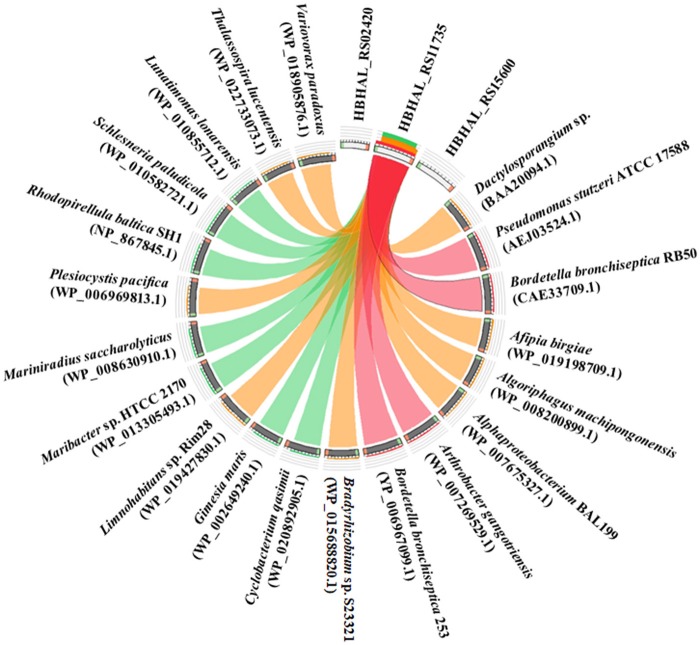
Circos plot showing the relationships between the products of three candidate genes (HBHAL_RS02420, HBHAL_RS11735, HBHAL_RS15600) and proteins annotated as PH-4 in GenBank. The plot was generated with Circoletto. The ribbons between the three candidate proteins and GenBank PH-4 proteins represent their local alignments and the ribbon colors indicate their amino acid sequence identities (no ribbons, <10%; blue, 10–15%; green, 15–25%; orange, 25–40%; red, >40%).